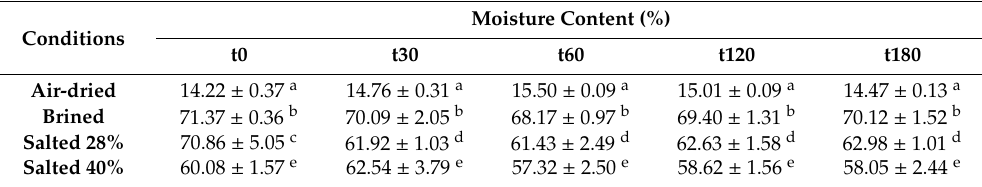
Table 1. Moisture content of Ulva rigida submitted to di ff erent preservative processes (air-drying, brining, salting at 28% and 40%), over storage up to 180